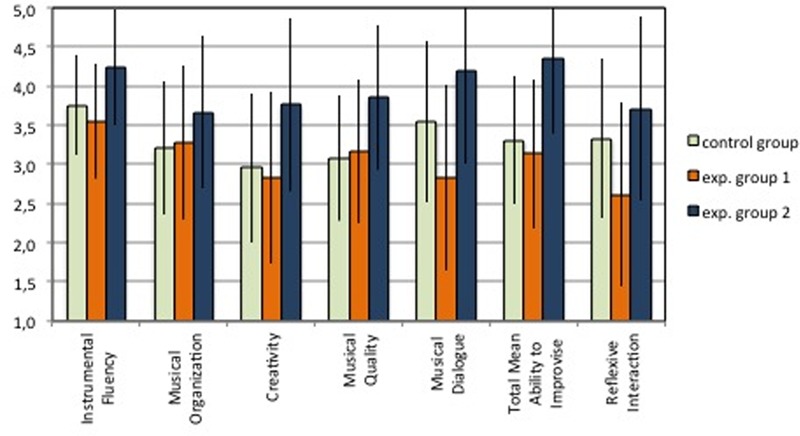
Duet task: Scores for each evaluative criteria, Total score of Ability to Improvise, and score of Reflexive Interaction (means). The error bars indicate the 95% confidence intervals.